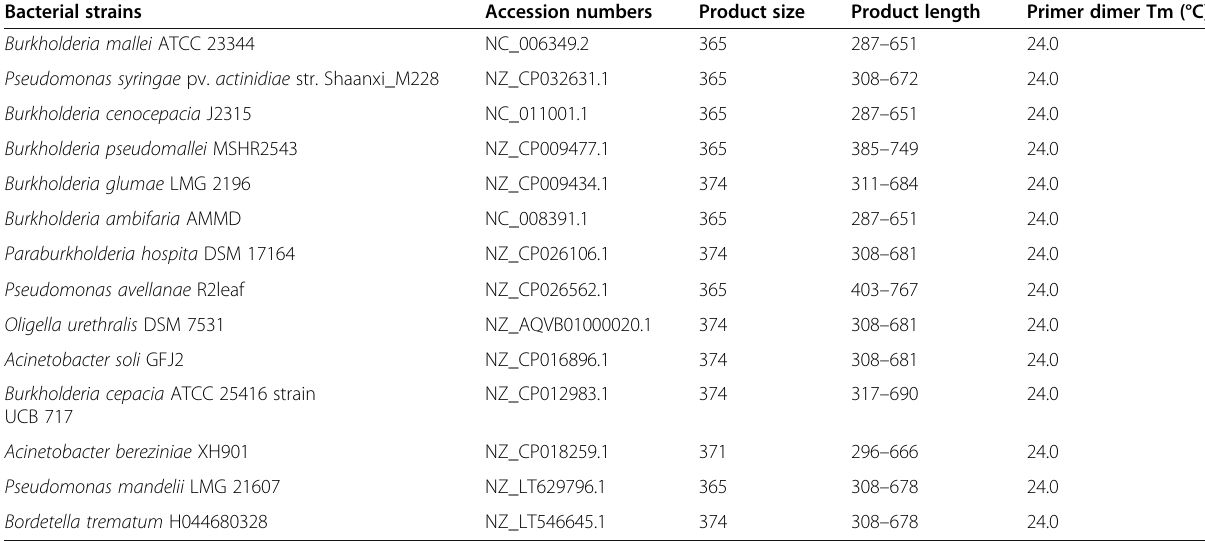
Table 7 In silico PCR analysis of primer pair catAf/catAr with targeted sequences Bacterial